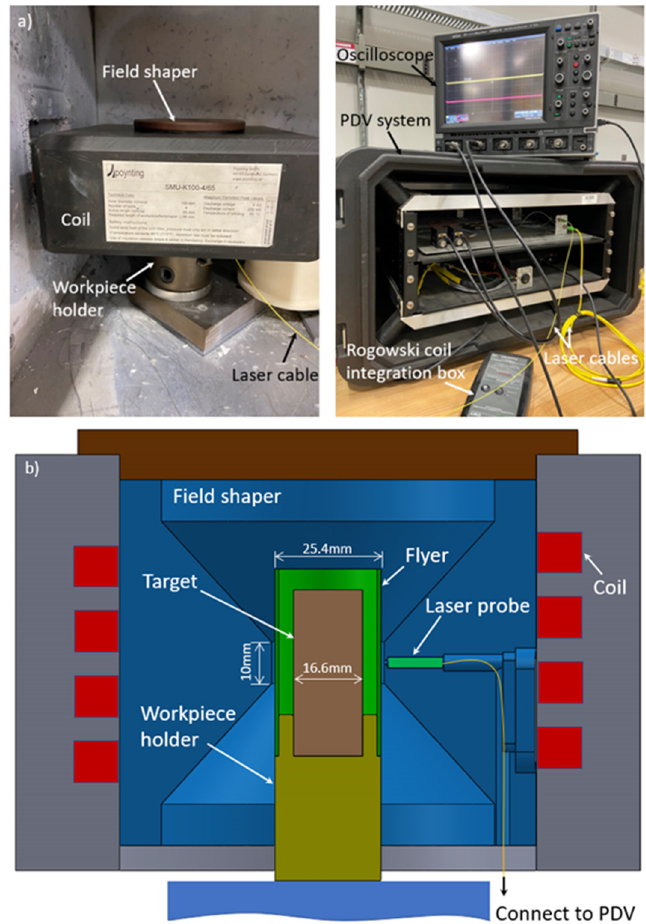
Figure 4. ( a ) Experimental setup and PDV system, ( b ) schematic of coil, field shaper, and workpieces.